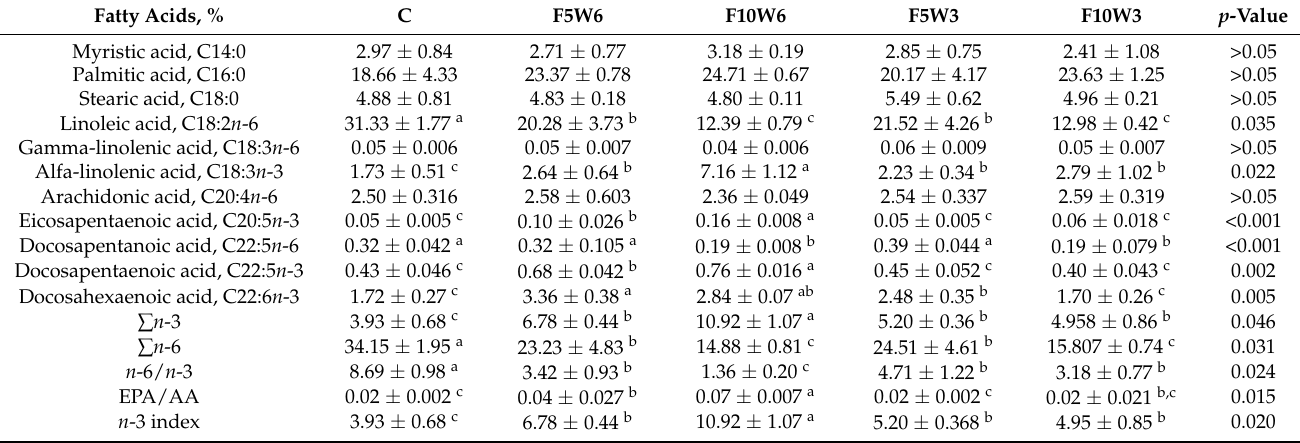
Table 6. Fatty acid composition of m. gluteobiceps fat (means ± SD).